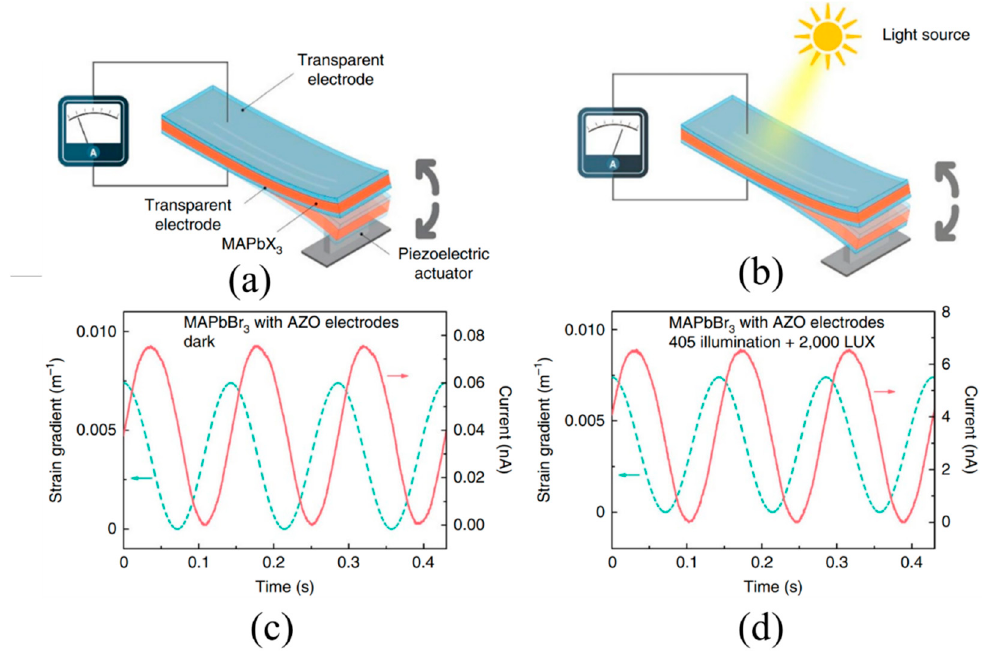
Figure 24. Cantilever bending the halide capacitors (where X is Cl, Br, or I) with transparent electrodes in the dark ( a ) or under light ( b ). The evolution of the collected current and strain gradient with time in the dark ( c ) or under light ( d ). Reprinted with permission from [78]. Copyright 2020 Springer Nature.